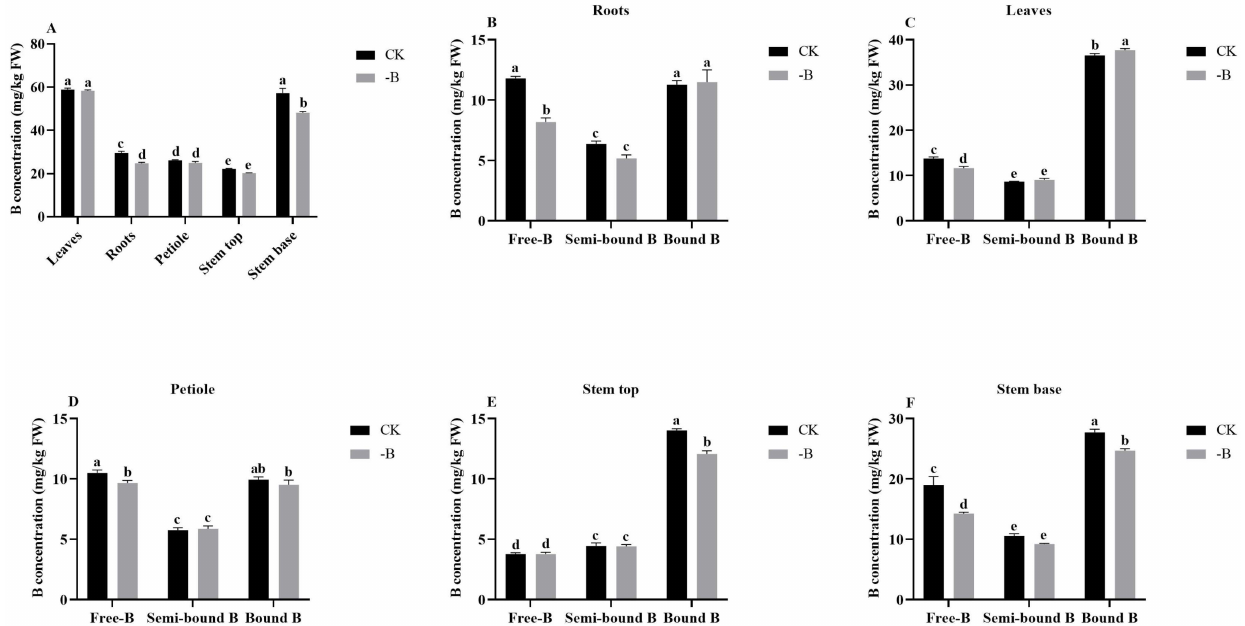
Figure 1. Total B concentration in P. betulaefolia under B-deficient conditions. ( A ) Total B concen- tration in different tissues. ( B – F ) refer to three B forms in different tissues. Values are means of three replicates ± SE. Bars with different letters indicate significant differences for the same B level at p <